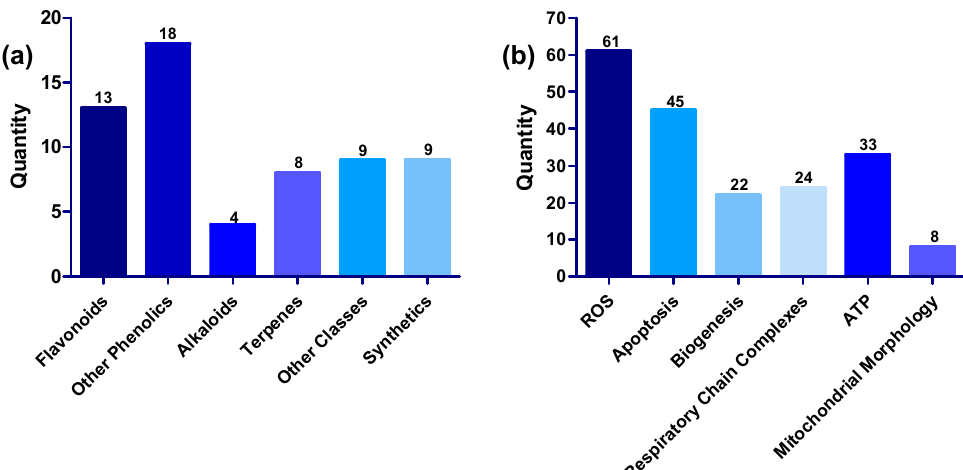
Figure 9. ( a ) Distribution of compounds across various structural classes of flavonoids, phenolic compounds, alkaloids, terpenes, other structural classes, and synthetic compounds. ( b ) Distribution of compounds across various targets, including ROS, apoptosis, biogenesis, respiratory chain complexes, ATP, and mitochondrial morphology.